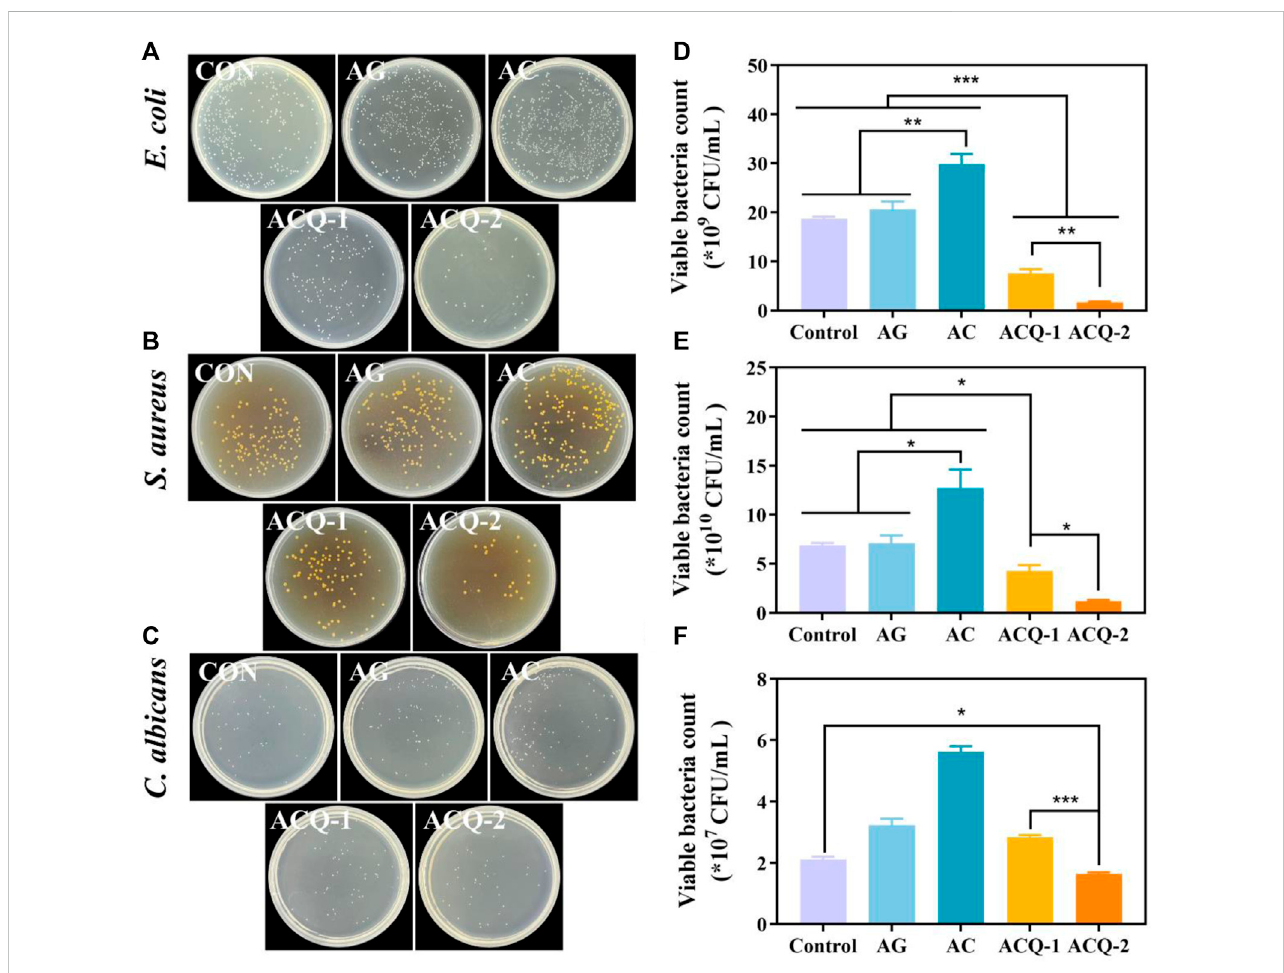
FIGURE 5 (A – C) Bacterial and fungus colonies, and (D – F) quantitative analysis of viable bacteria of E. coli , S. aureus , and C. albicans on agar plates after being co- cultured with the sponges, respectively. Data are mean ± SD (n = 3) (* p < 0.05, ** p < 0.01, *** p <